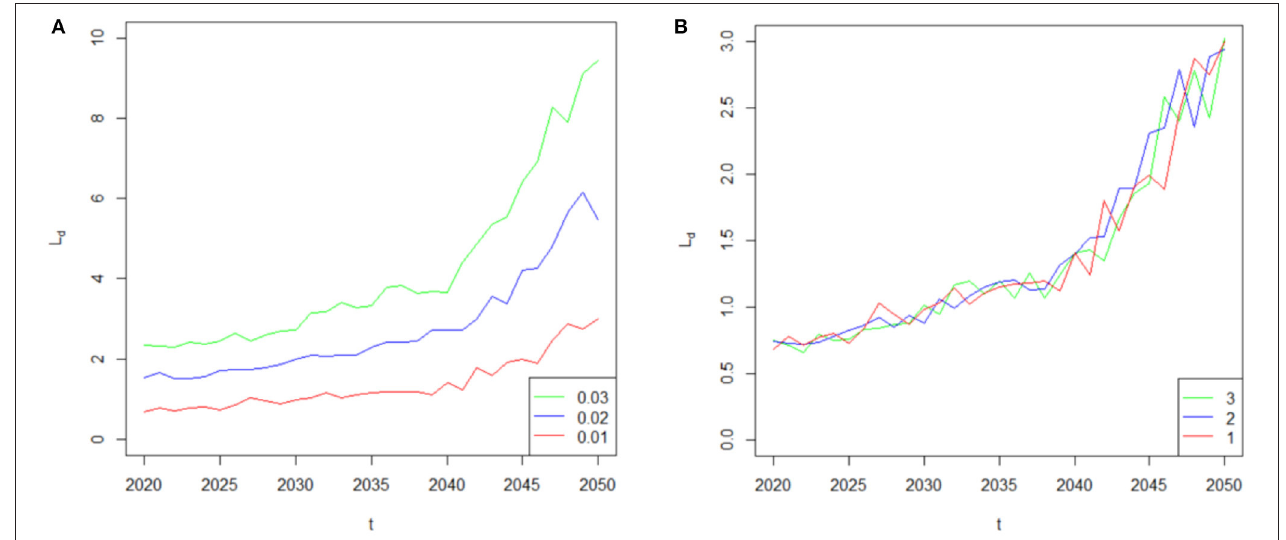
FIGURE 6 | (A) Sensitivity of the liability difference to the parameter λ τ . (B) Sensitivity of the liability difference to the parameter κ .